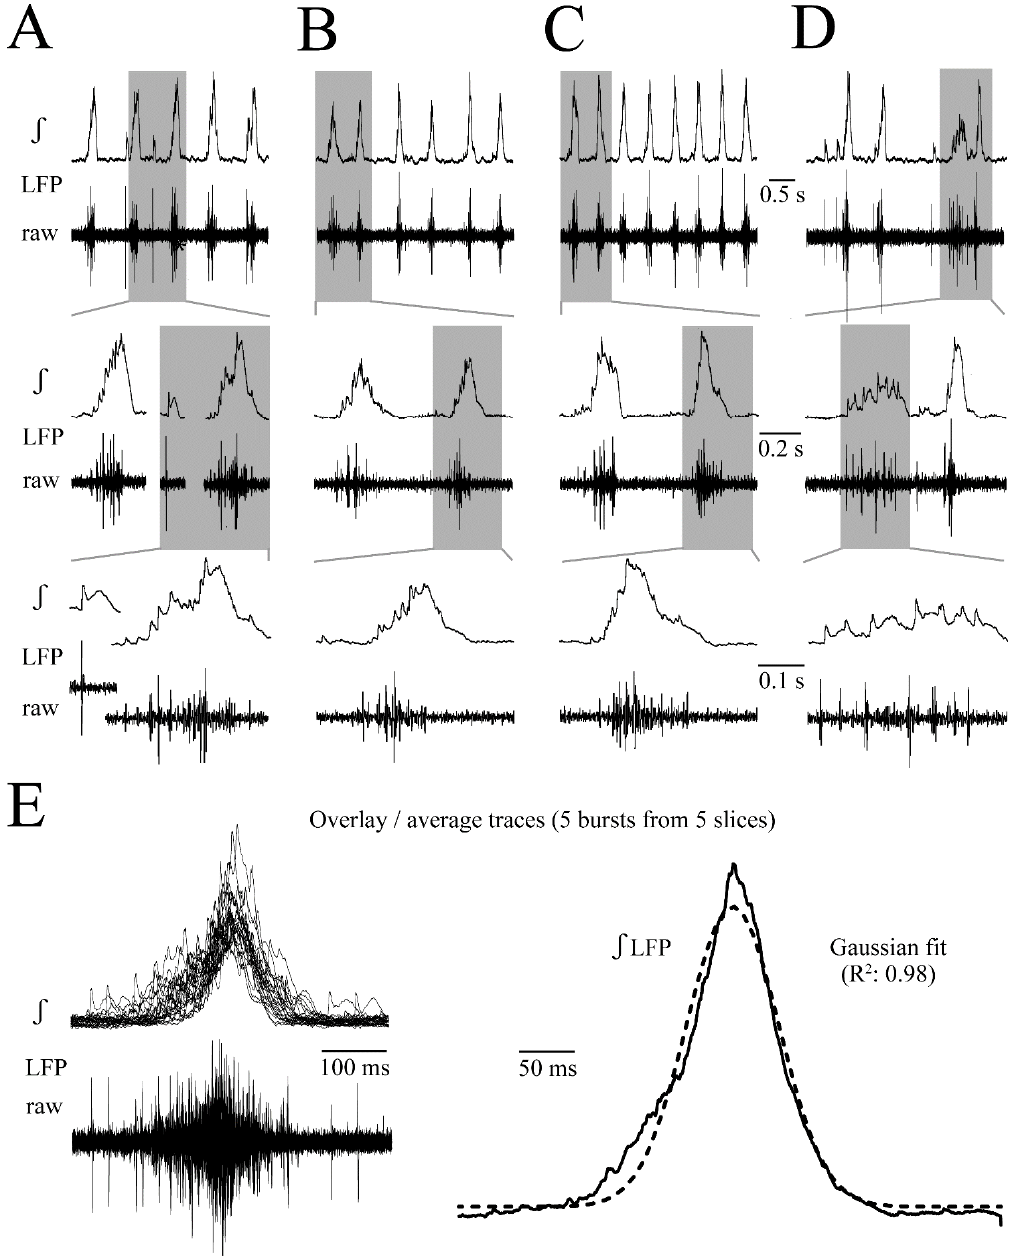
Figure 1. Spontaneous local field potential (LFP) in newborn rat locus coeruleus (LC) slices. ( A ) LFP was recorded with 40–60 μ m outer tip Ø superfusate-filled suction electrodes positioned on the slice surface in the LC neuron somata area [see (Figure 2A)]. The differentially-amplified (×10 k) and bandpass-filtered (0.3–3 kHz) ‘raw’ signal was also recorded after integration ( , time-constant 50 ms). LFP examples in ( A – C ) from three different slices show that the integrated signal has a similar shape and occurs at a quite regular rate and amplitude. However, displaying individual LFP events at higher time resolutions in the middle and lower traces indicates in raw traces that active neuron numbers, their distance from the electrode (indicated by spike amplitude) and time points of their discharge can differ. Additionally, in ~30% of slices, the LFP pattern is less regular and smaller amplitude events typically show a more dispersed pattern ( D ). ( E ) Traces on the left overlaid from five consecutive LFPs of the slices shown in ( A – C ), plus two further slices with similarly regular patterns. Traces on the right represent the average of integrated traces on the left plus a Gaussian fit for its kinetics revealing a bell-shaped LFP